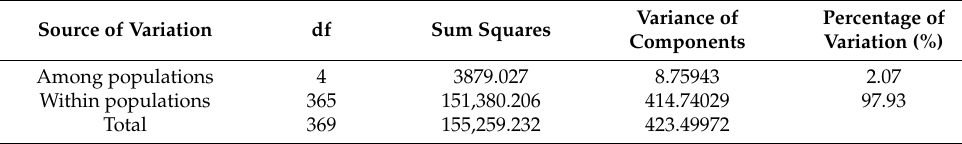
Table 5. Analysis of molecular variance of